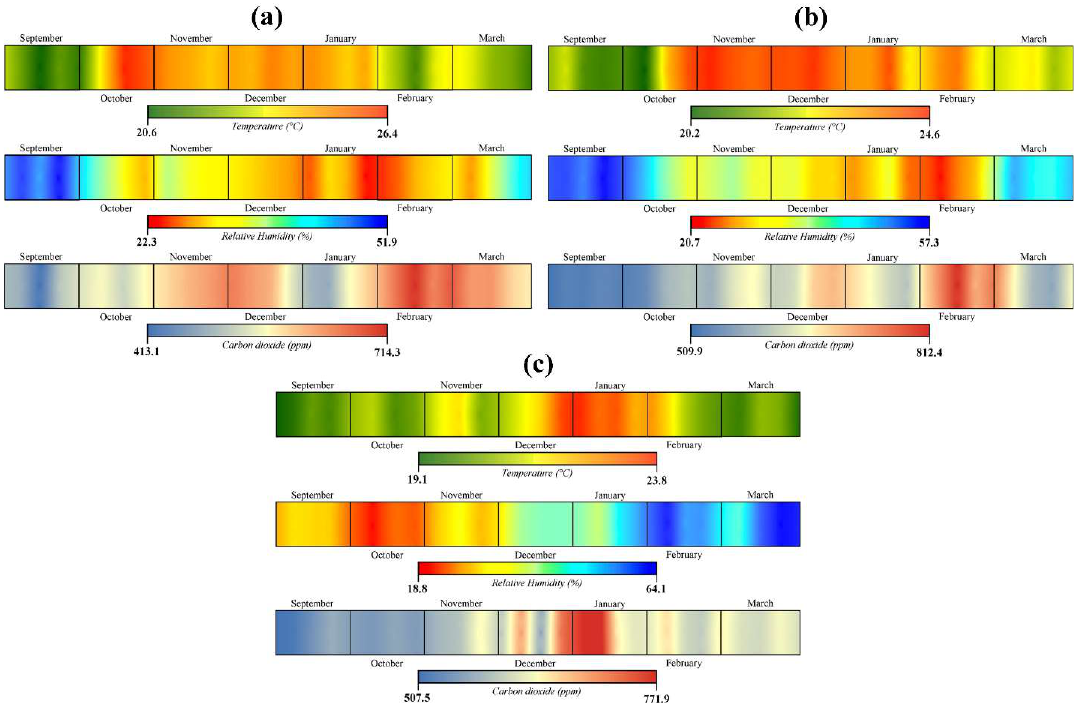
Figure 5. Fluctuations of the average weekly values of temperature (T), relative humidity (RH) and carbon dioxide (CO 2 ) concentration (( a )—The great hall–1st floor; ( b )—The exhibition hall–Ground floor; ( c )—The bedroom–1st floor).